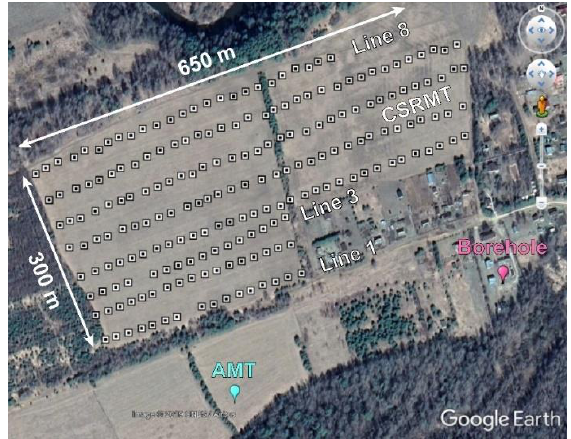
Figure 6. Map of the study area from which the acquisition geometry was taken for the numerical simulation. The boxes depict receiver stations. The receiver lines are numbered from 1 to 8. The receiver grid consisted of 192 receiver stations and two orthogonal transmitter lines (see Figures 6 and 7). All receivers had azimuth 68.5°. Coordinates of receiver stations and transmitter lines can be found in the supplementary materials File S1. The five components of the electromagnetic field were simulated.